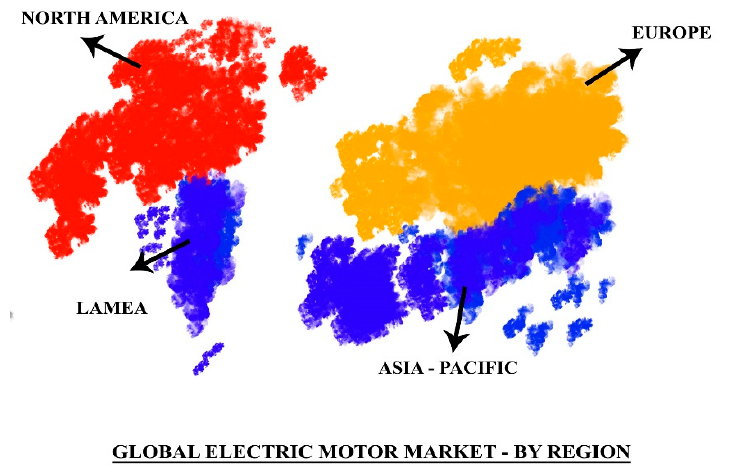
Figure 1. Global electric motor market record.